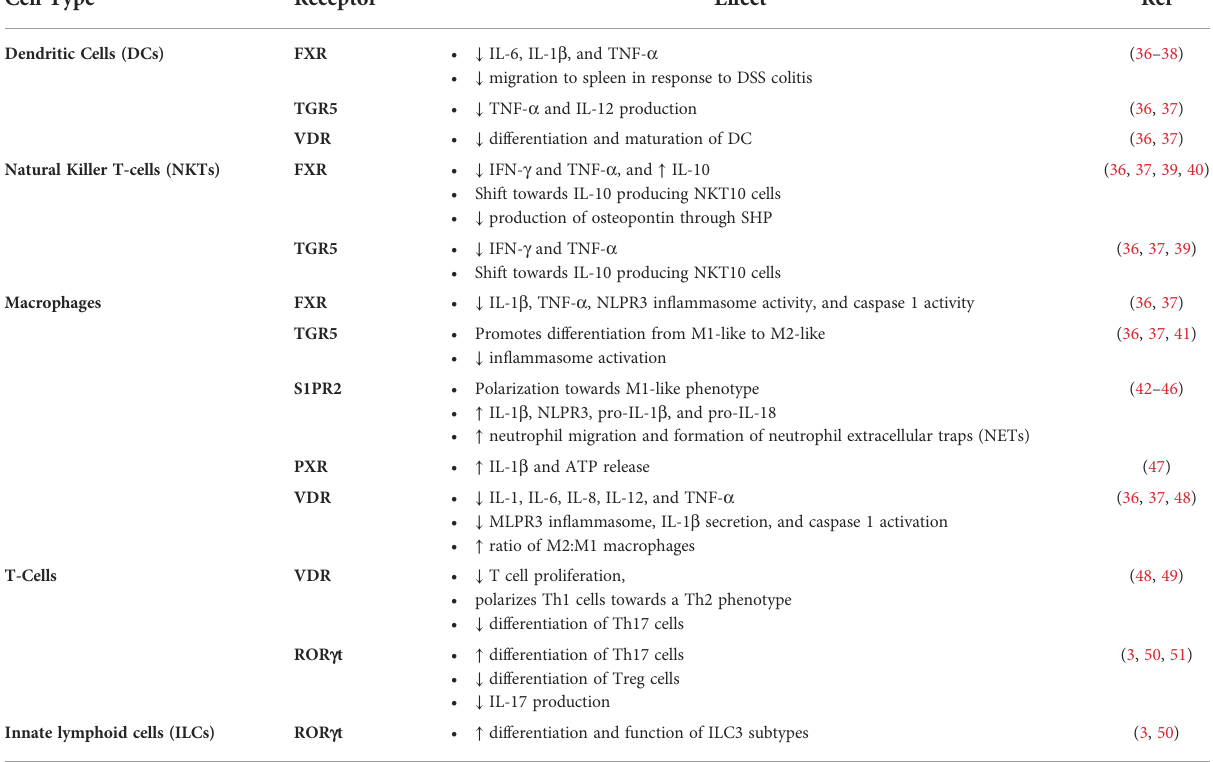
TABLE 1 Effects of Bile Acid Receptor Activation in Immune